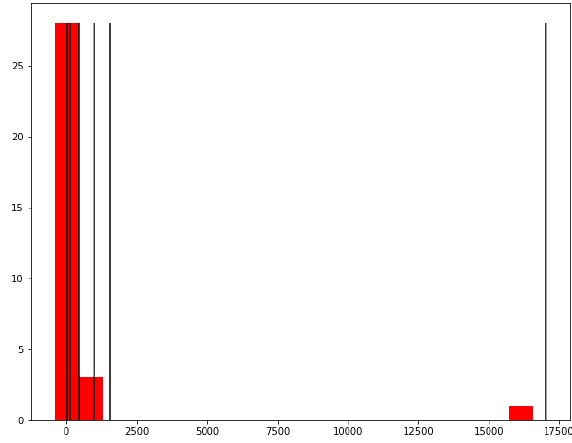
Figure 3 . Graphic generated by Jenkspy with the data distribution and the limits of classes.